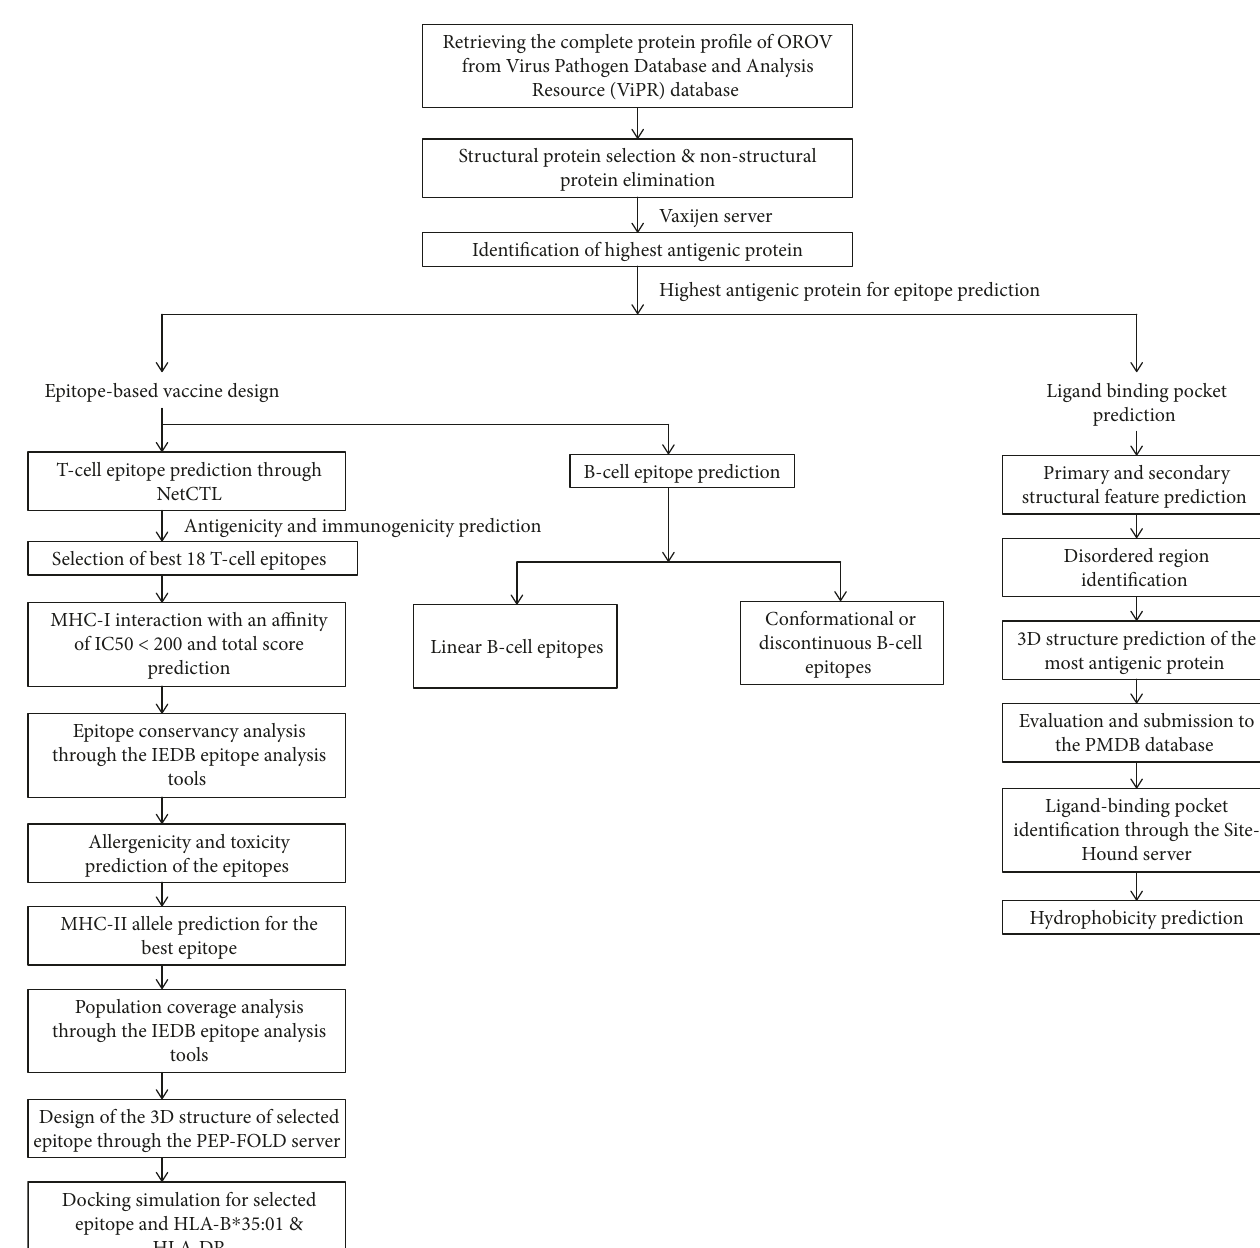
Figure 1: Schematic representation of epitope-based vaccine design and ligand-binding pocket prediction against the OROV